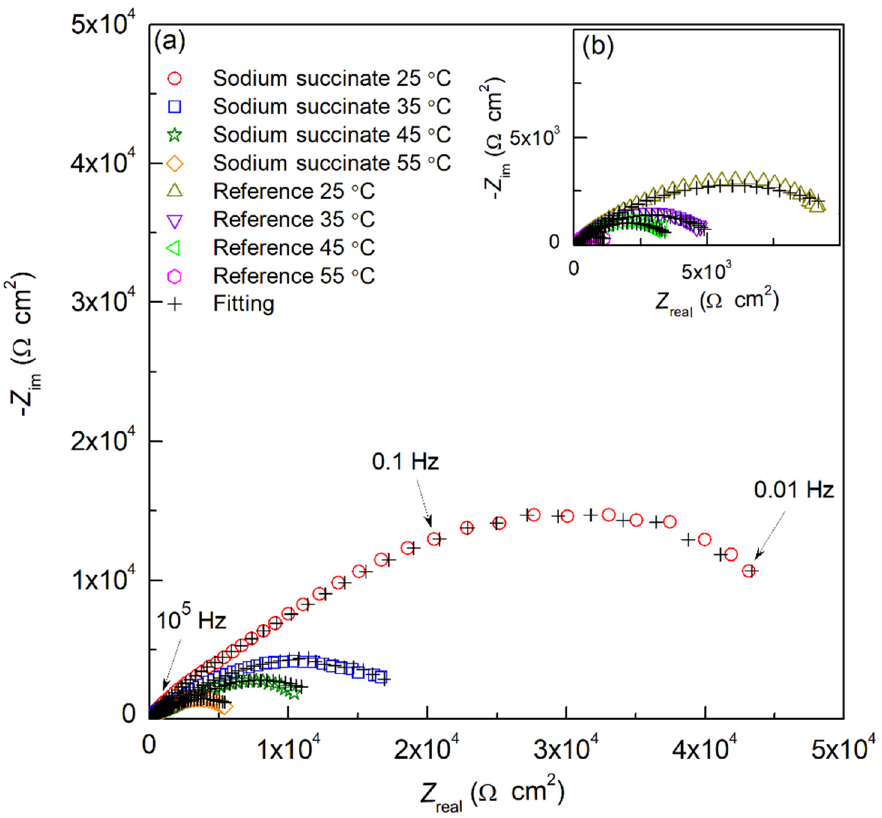
Figure 3. EIS curves for carbon steel rebars in 0.6 M Cl − SCPS in the ( a ) presence, and ( b ) absence of 0.6 M sodium succinate at 25, 35, 45, and 55 °C.